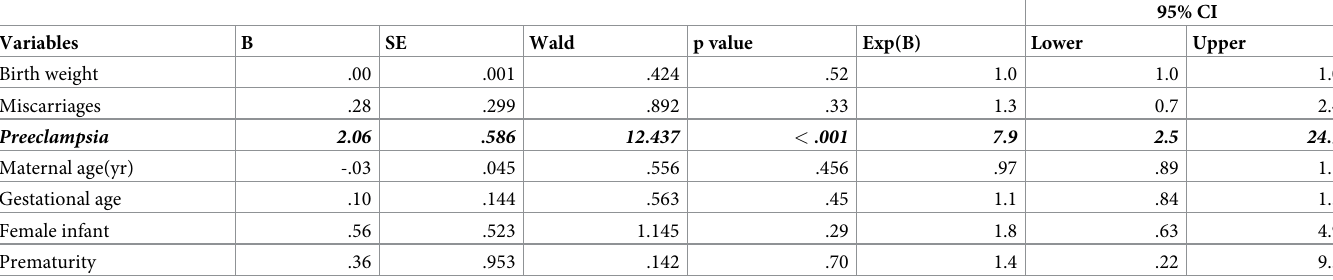
Table 3. Logistic regression estimates of the relationship between some study variables and congenital heart disease (CHD).